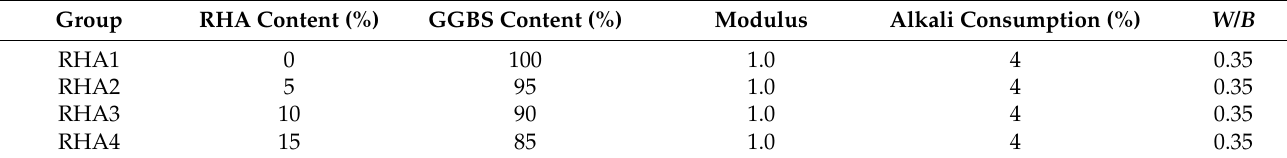
Table 2. Mix proportion of clean slurry.